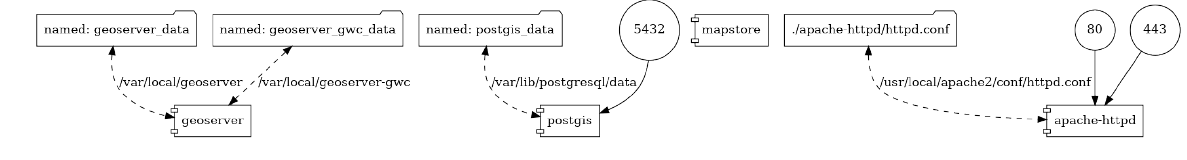
Figure 10. eMOTIONAL Cities SDI docker-compose structure